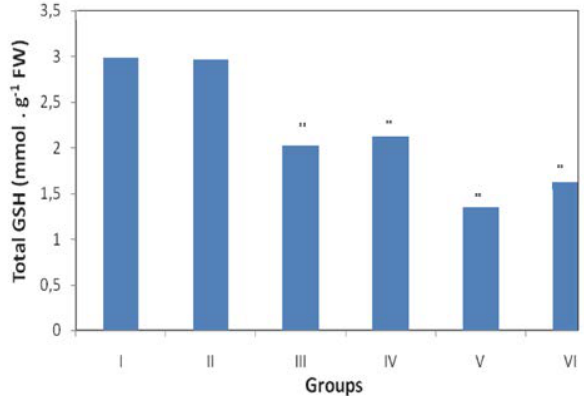
Figure 2. Effect of chlorpyrifos and deltamethrin on the wheat GSH level. CP and DM were administered in different doses. Group I (con- trol group), group II (1 mg kg –1 CP group), group III (15 mg kg –1 CP group), group IV (5 mg kg –1 DM group), group V (35 mg kg –1 DM group), group VI (combination group of 1 mg kg –1 CP and 5 mg kg –1 DM). Values are represented as means ± S.D. of eight plants in each group. ** Significantly different from control at P <